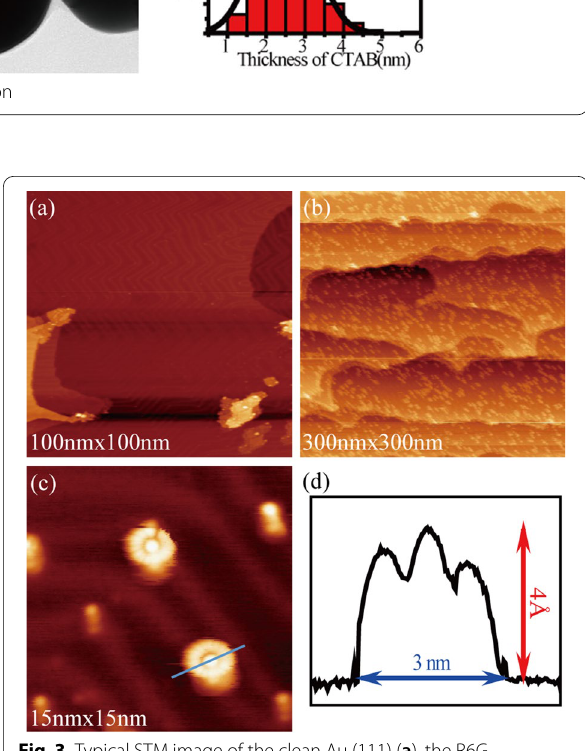
Fig. 3 Typical STM image of the clean Au (111) ( a ), the R6G molecules on Au (111) ( b ) and a single R6G molecular ( c ). d Line profile across a single R6G